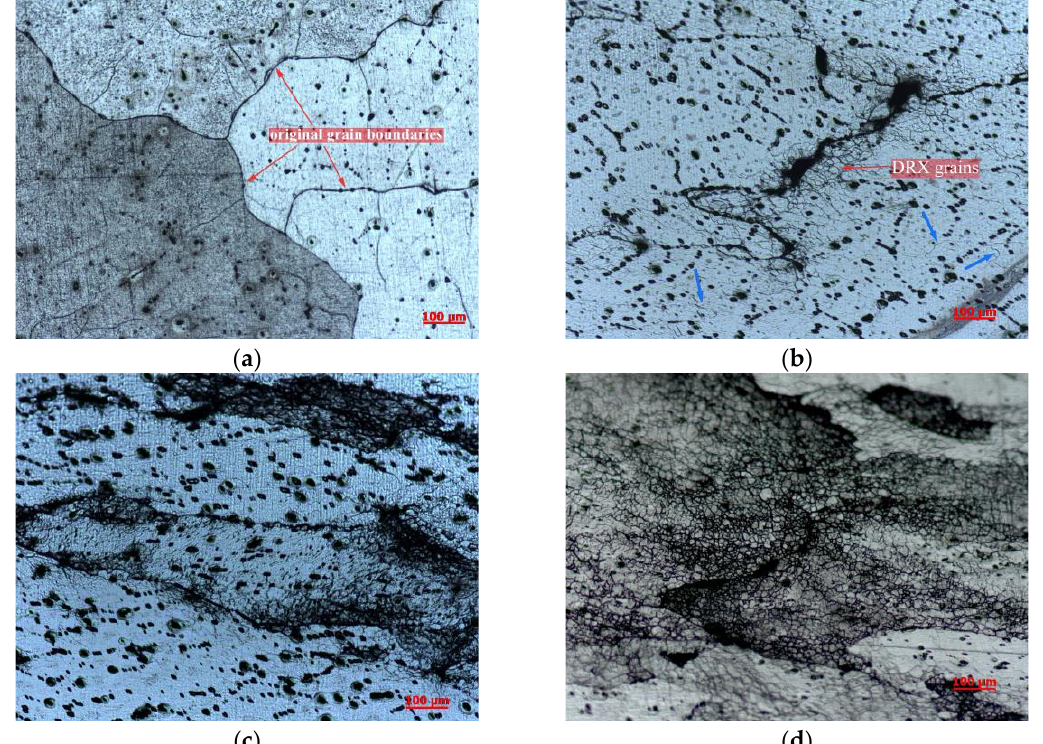
Figure 11. The DRX evolution of Fe-Cr-Al-La stainless steel at 1000 ◦ C and 0.1 s − 1 to various strains: ( a ) 0, ( b ) 0.223, ( c ) 0.511, and ( d )